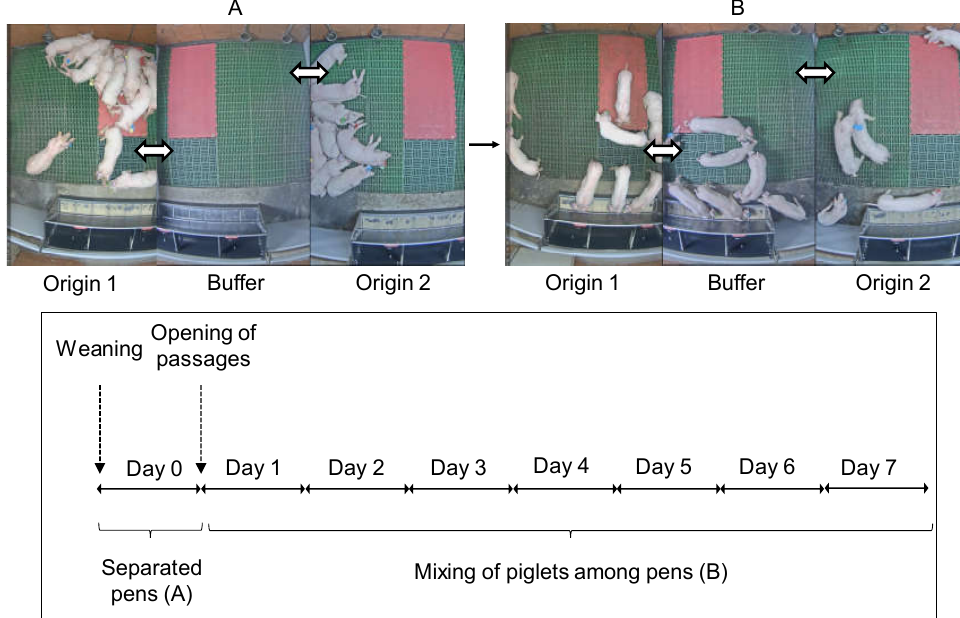
Figure 1. Experimental design. ⬄ — passage, A — before mixing, B — after mixing .